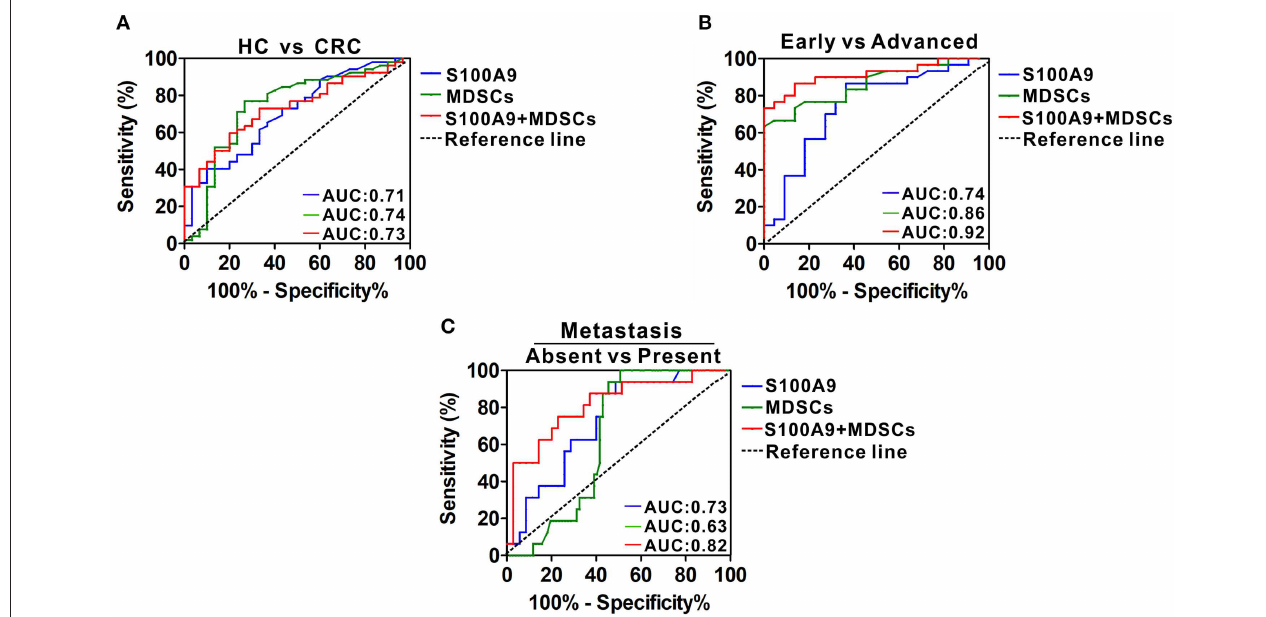
FIGURE 7 | Diagnostic power of serum S100A9 and MDSCs frequency for CRC progression. (A) ROC curves of serum S100A9, MDSCs, and their combination for detecting CRC. (B) ROC curves of serum S100A9, MDSCs and their combination for identifying advanced stages from early stages in CRC patients. (C) ROC curves of serum S100A9, MDSCs, and their combination for detecting metastasis from none in CRC patients.